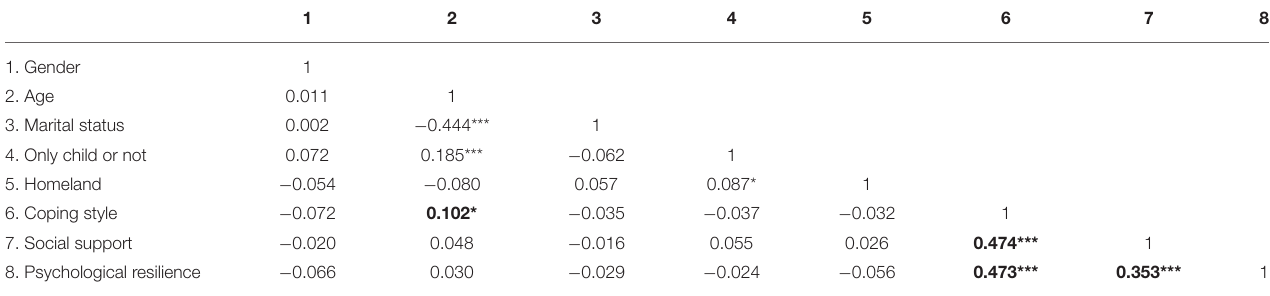
TABLE 2 | Correlation between sociodemographic data and main variables.